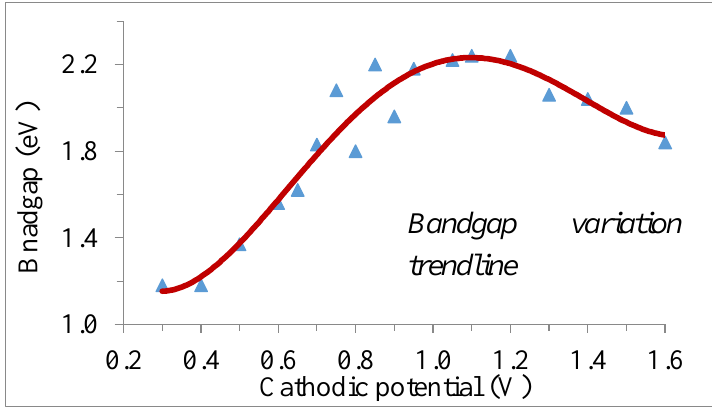
Figure 5. Energy bandgap variation for CuInGaSe 2 as a function of the cathodic voltage.